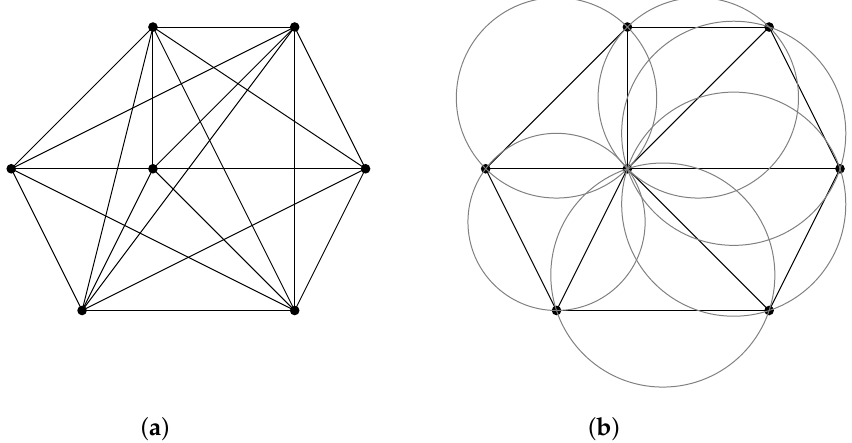
Figure A2. Comparison of a Delaunay triangulation and a complete graph on a small example. ( a ) Complete graph. ( b ) Delaunay triangulation with circumcircles.